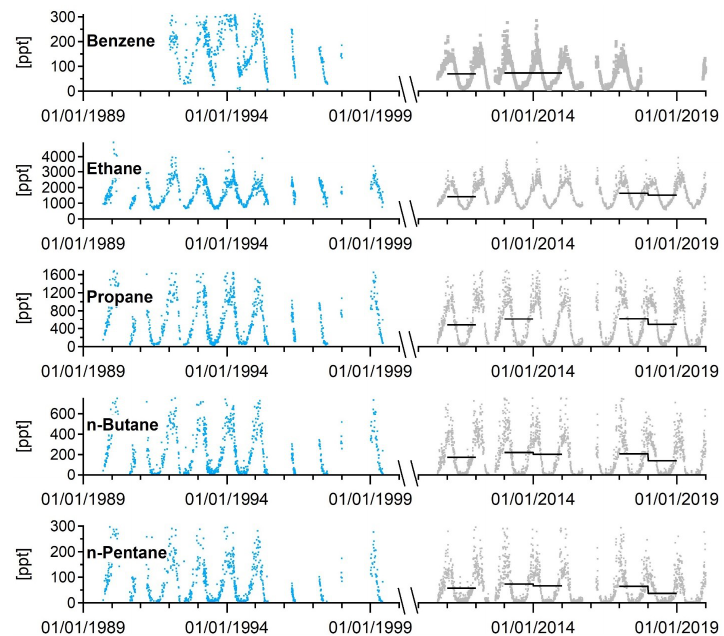
Figure 14. Non-methane hydrocarbon (NMHC) mixing ratios at the Zeppelin Observatory from “grab samples” (two to three steel flask samples of 20min, per week, shipped and analysed at NILU’s laboratory) for 1989–2000 (blue) and averaged NMHC from the Medusa GCMS instrument (grey dots) and yearly averaged NMHC from the Medusa GCMS instrument for 2010 to 2019. Daily and annual means calculated only where data coverage is 75% of the total day or year, respectively. Table 7. Non-methane hydrocarbons measured at the Zeppelin Observatory; their chemical formulas, atmospheric lifetime, mean mixing ratios in 2019, and fitted trends; and the estimated percentage change over the entire period 1989–2019 as defined as 100 ×[ X 2019 /X 1989 − 1 ] where significant. Compound Chemical Lifetime 1 Mean mixing Trend 2 Total change formula ( ∼ days) ratio (ppt) (pptyr − 1 )